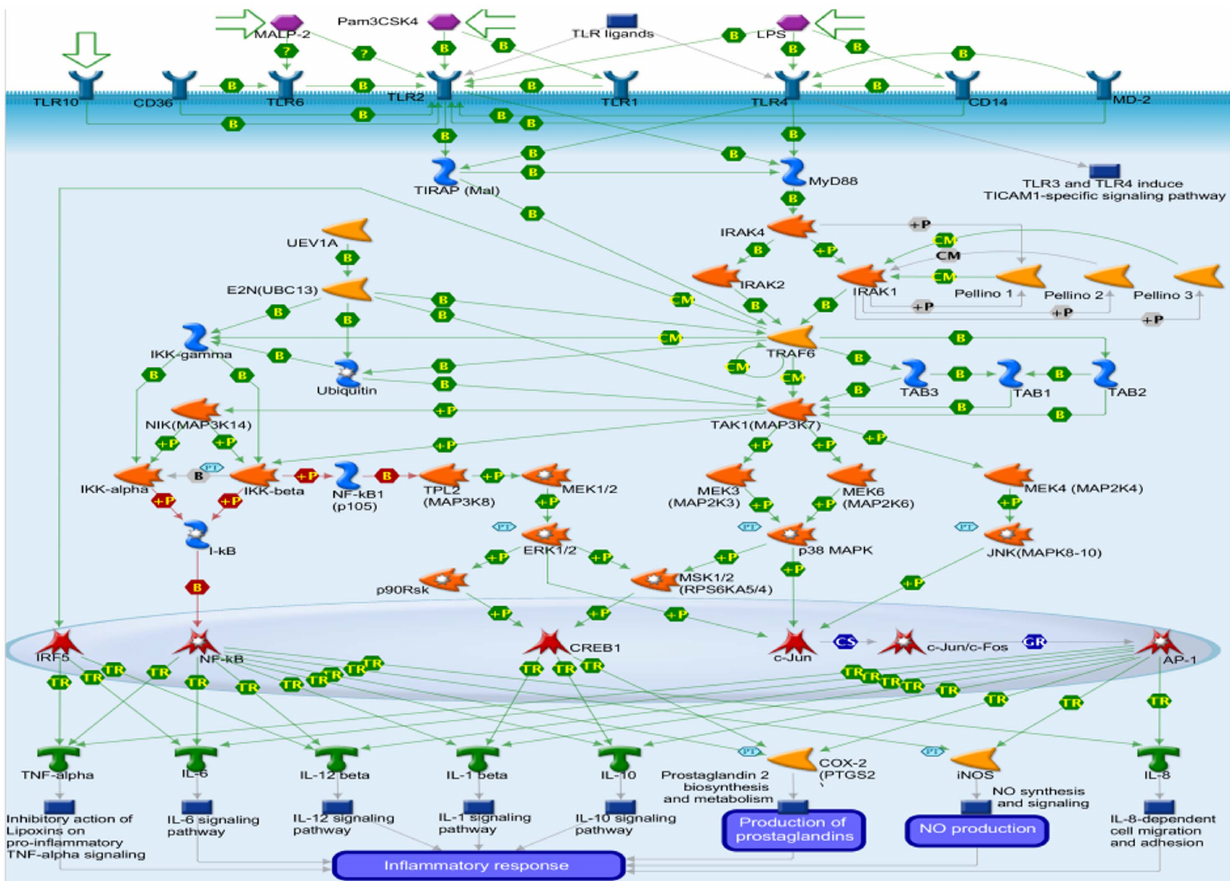
Figure 6. Signaling pathway map screened by Metadrug.